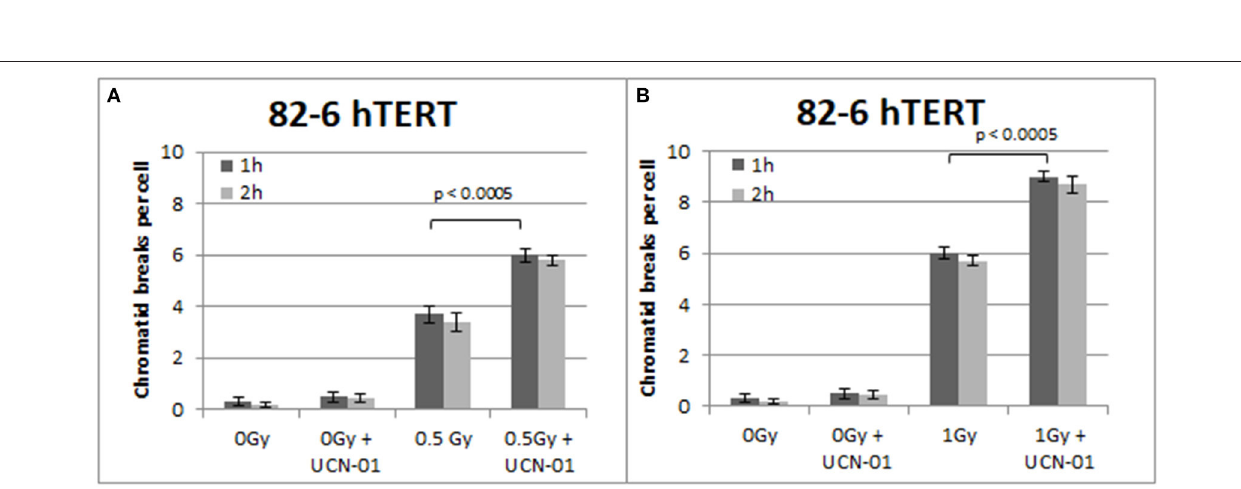
of the highly radiosensitive AT cells used as an internal control (100% radiosensitive) (26). The values of IRS parameters for the 82-6 hTERT and RPE cell lines treated with Caffeine, VE-821, and UCN-01 are also presented in Table 1